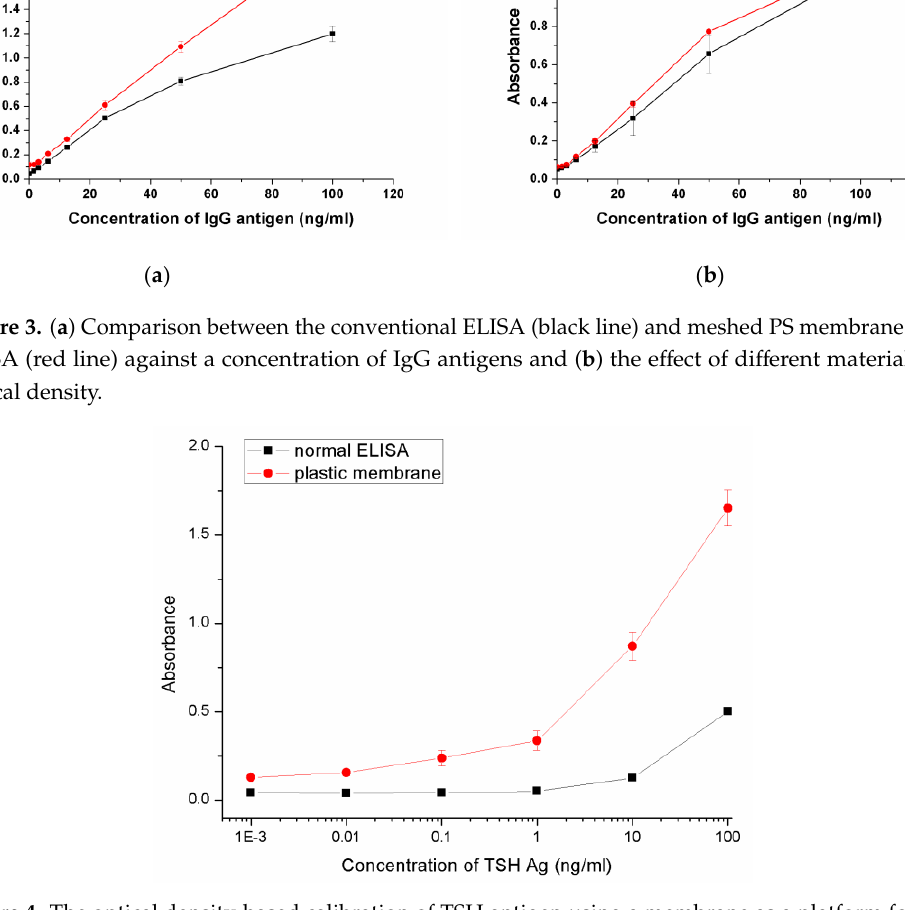
Figure 4. The optical density-based calibration of TSH antigen using a membrane as a platform for the immobilization of antibodies.